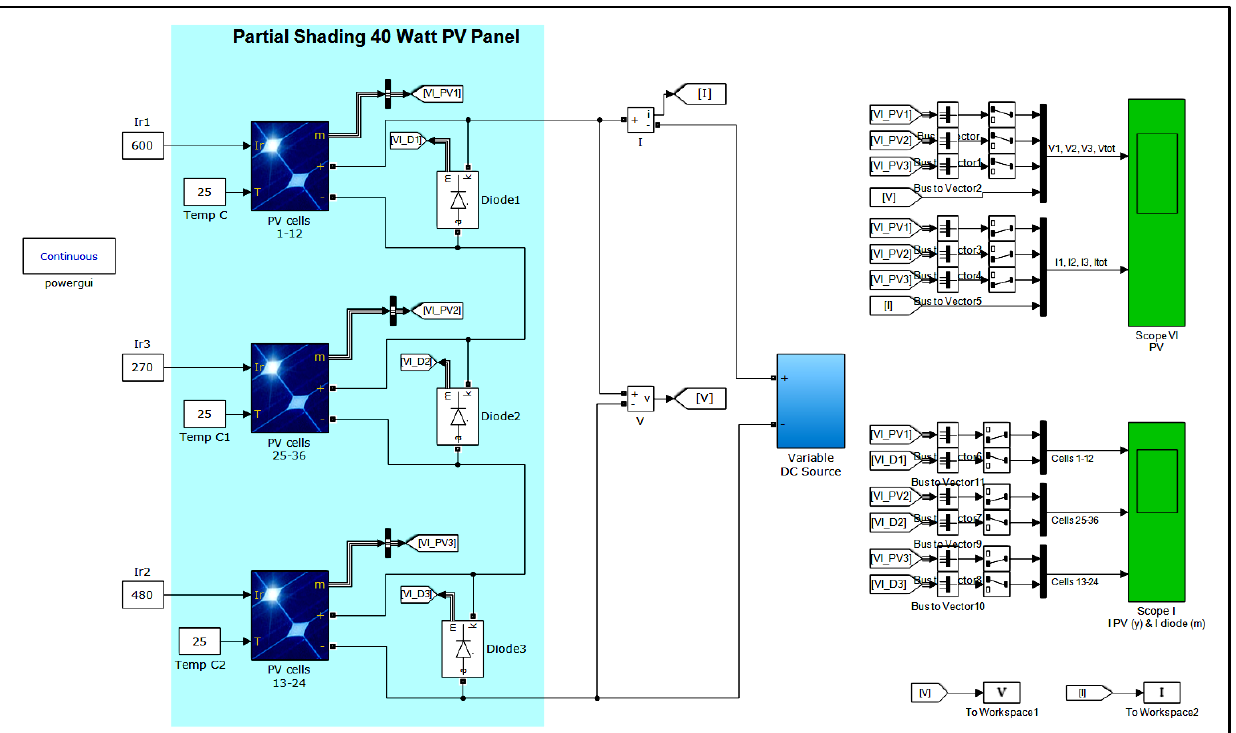
Figure 10. Shading-based simulation model of 40-Watt solar panel with bypass diode.